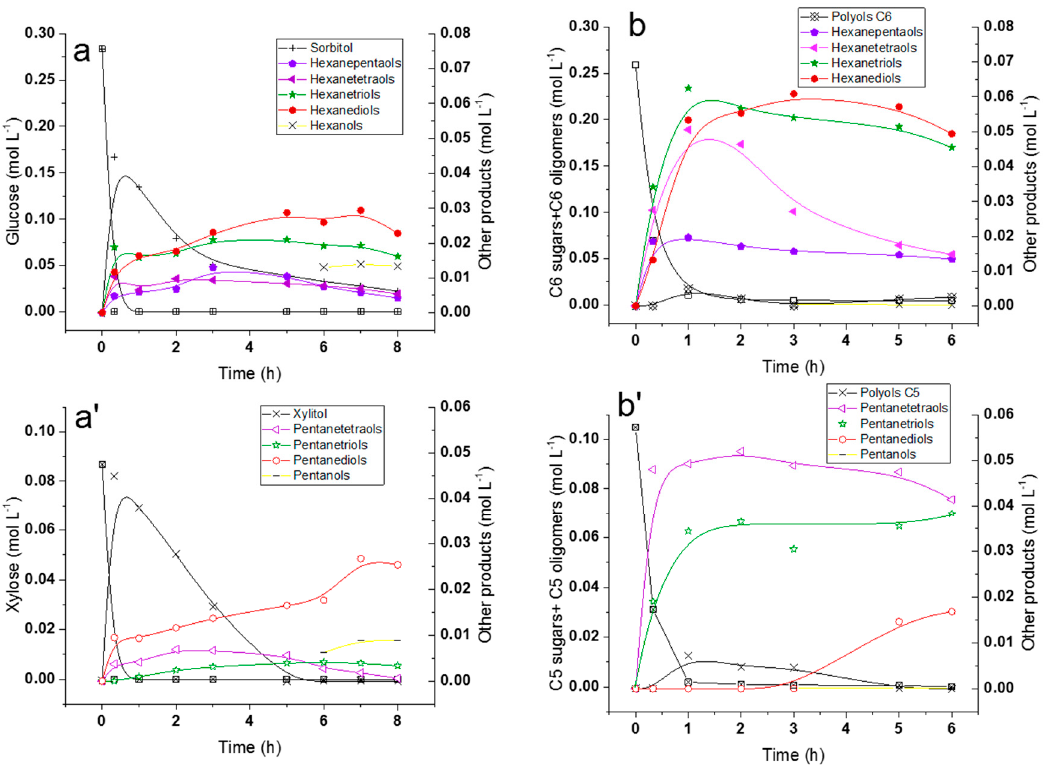
Figure 9. Temporal profiles of concentrations of sub-families during hydrogenolysis of ( a , a’ ) glucose/xylose mixture (2/1) and of ( b , b’ ) liquor of pine maritime over Rh-Re/ZrO 2 at 200 °C under 80 bar H 2 .